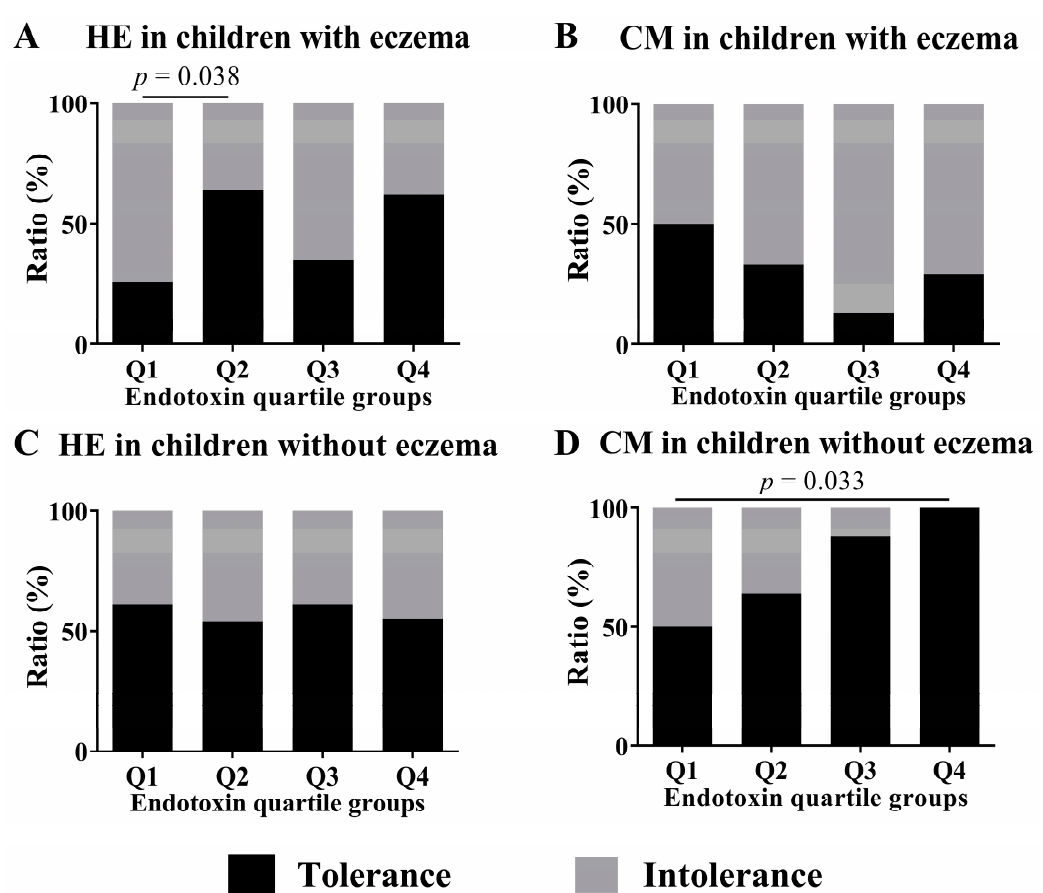
Figure 5. Subgroup analyses by the ratio of tolerance to intolerance at 2 years old in children who had HE and CM allergy in their first year of life and the presence of eczema to assess the association of endotoxin concentrations (Q1–Q4) collected from the mattresses of children at 18 months old. These show results in ( A ) HE in children with eczema, ( B ) CM in children with eczema, ( C ) HE in children without eczema and ( D ) CM in children without eczema. To calculate p -values, the values of quartiles were compared using Fisher exact test, with Q1 values as references.